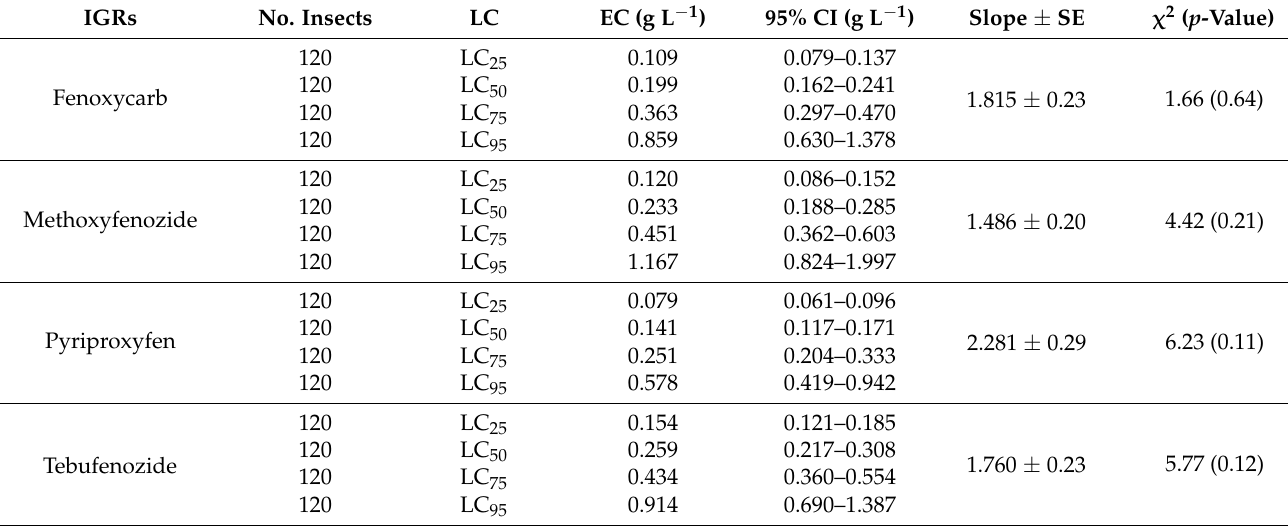
Table 1. Toxicity of insect growth regulators (IGRs) by contact exposure on Euprosterna elaeasa larvae (df = 5). Lethal concentration (LC) values were estimated based on concentration–mortality bioassay using Probit analysis. EC, estimated concentration; CI, confidence